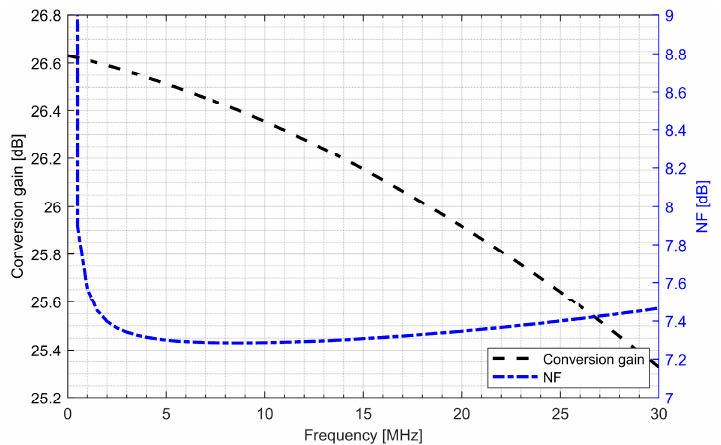
Figure 12. Conversion gain and noise figure characteristics of the L5/E5 band active balun and mixer.